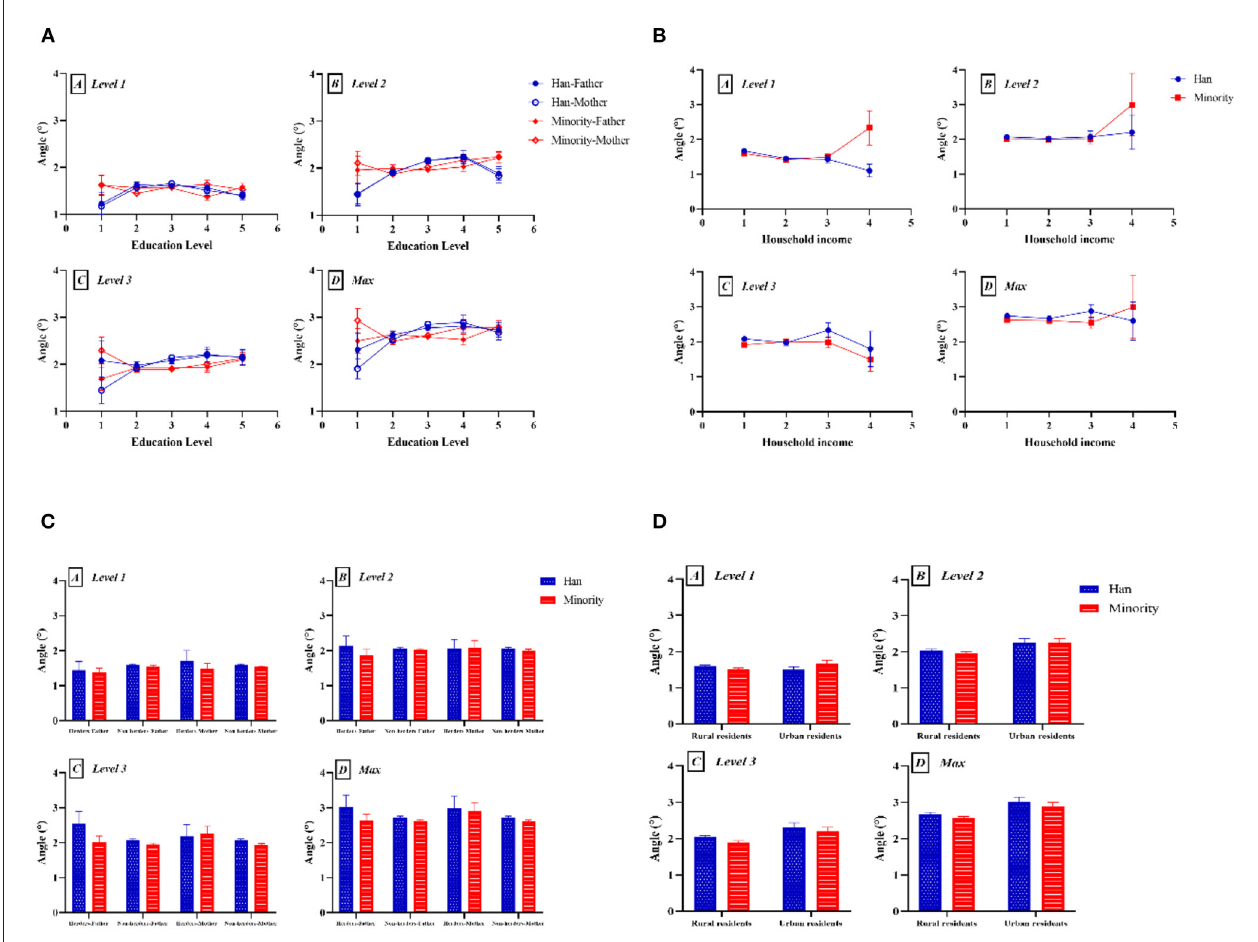
FIGURE 4 | Two-factor analysis of variance to assess differences in ATR value by ethnicity and SES-related factors: (A) education level; (B) household income; (C) occupation; and (D) hukou. (A) Level 1, proximal thoracic (T1–T4); (B) level 2, main thoracic (T5–T12); (C) level 3, lumbar (T12–L4); (D) Max, maximum value among the three